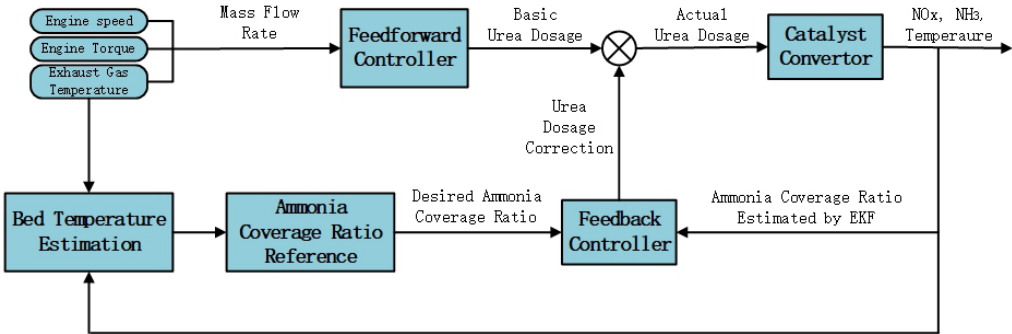
Figure 1. Schematic of the ammonia-coverage-ratio-based closed-loop control strategy.